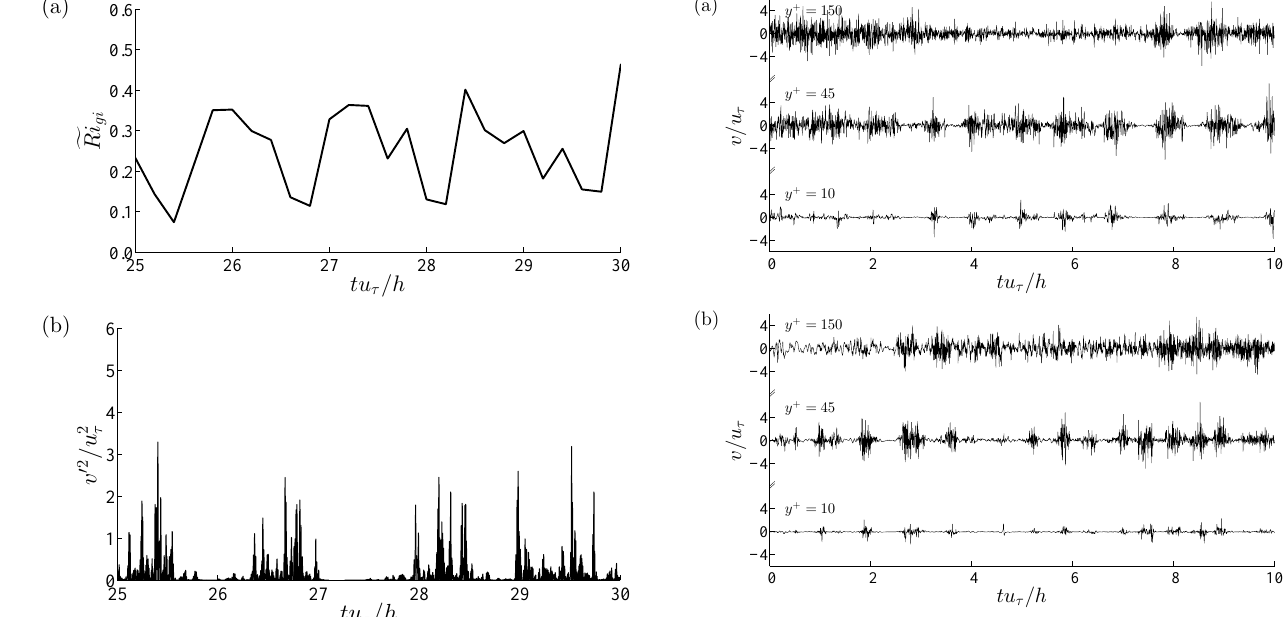
Figure 19. Time-series of (a) f Ri gi and (b) v (cid:48) 2 at the central-channel with y + = 90 ( Re τ = 180, Ri τ = 120).